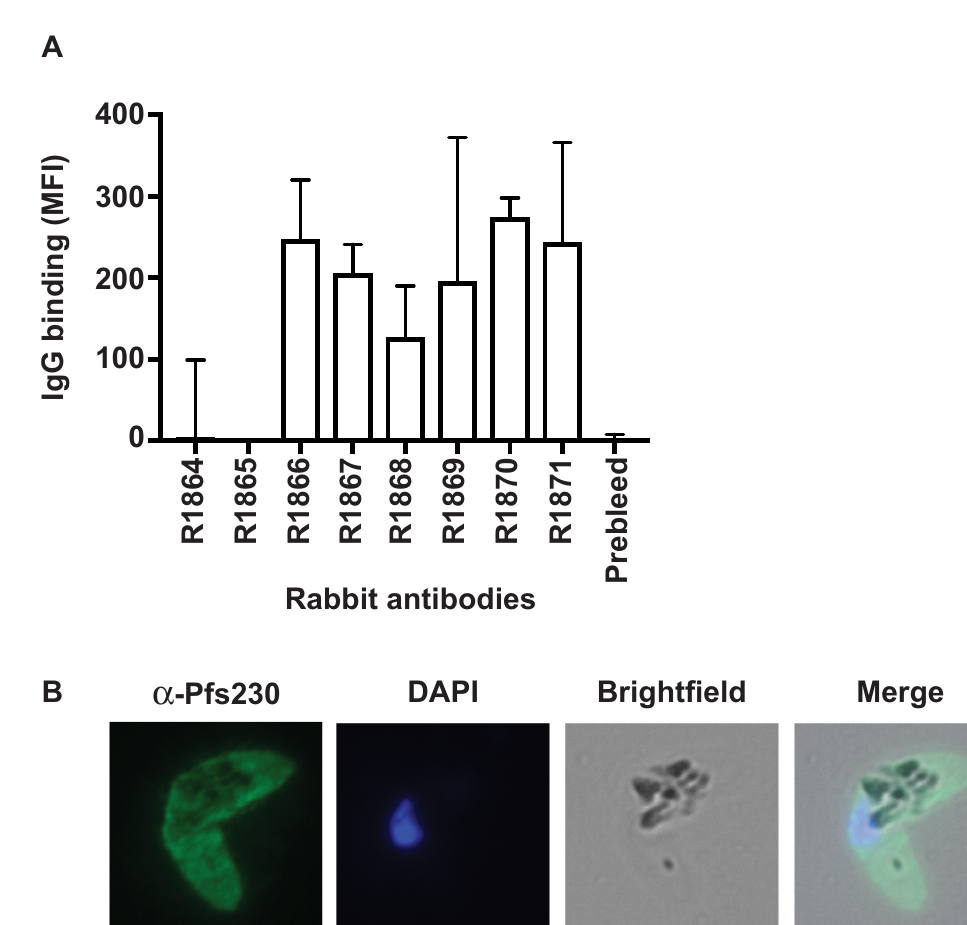
Fig 3. Characterising the antibody function of rabbits immunised with chimeric VLPs. A . Total antibody binding to the surface of native P . falciparum gametocytes (stage V gametocyte-infected erythrocytes were permeabilised with saponin) measured by flow cytometry. Whole serum from rabbits immunised with Pfs230c-dS/dS VLPs were used (n = 8). Antibody levels are expressed as geometric mean fluorescence intensity (MFI); bars represent mean and range of samples tested in duplicate. B . Immunofluorescence microscopy demonstrates the recognition of the native gametocyte surface by serum antibodies from rabbits immunised with Pfs230c-dS/dS VLPs (R1870; green). Cells were fixed with 90% acetone and 10% methanol, and DAPI was used to stain nuclear DNA (blue). Representative images taken of gametocytes labelled with R1870 are